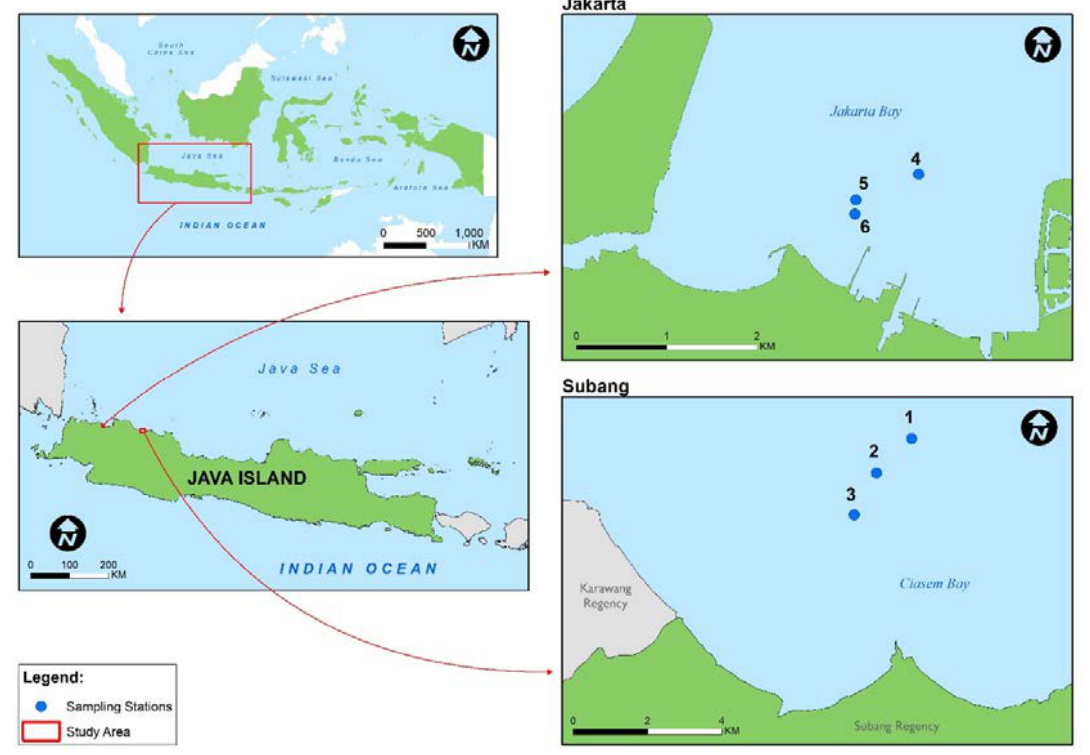
Fig. 1: Geographic location of the study area at disturbed and intact sites on West Java coast, Indonesia